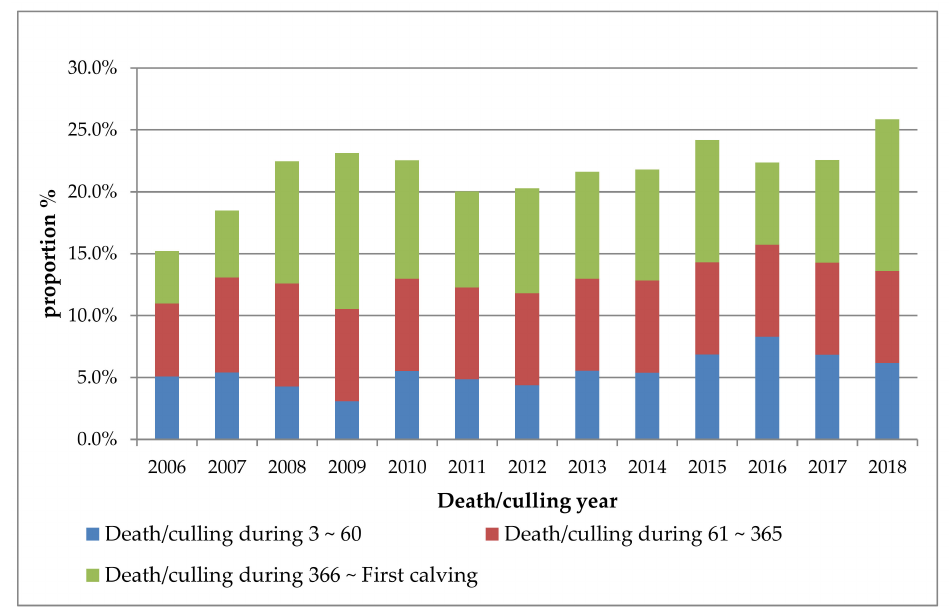
Figure 1. Mortality-culling rates of dairy calves and replacement heifers in di ff erent life stages over